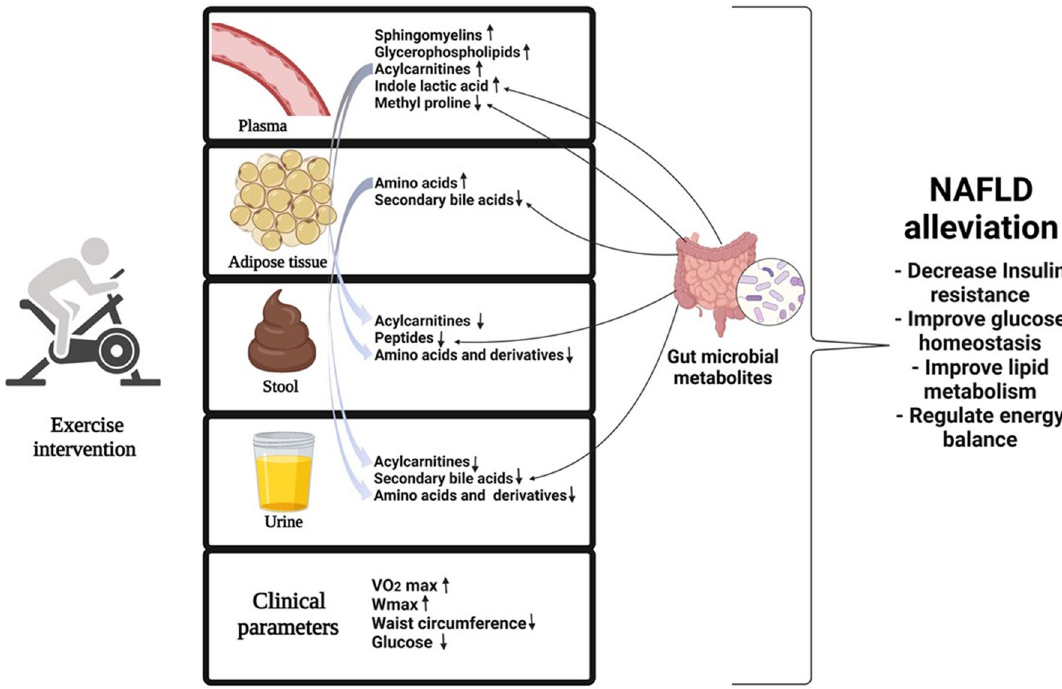
Figure 4. A 12-week high-intensity interval training has beneficial ameliorating effects in NAFLD subjects at whole body level by regulating glucose metabolism and promoting alterations in amino acid, lipid, and bile acid